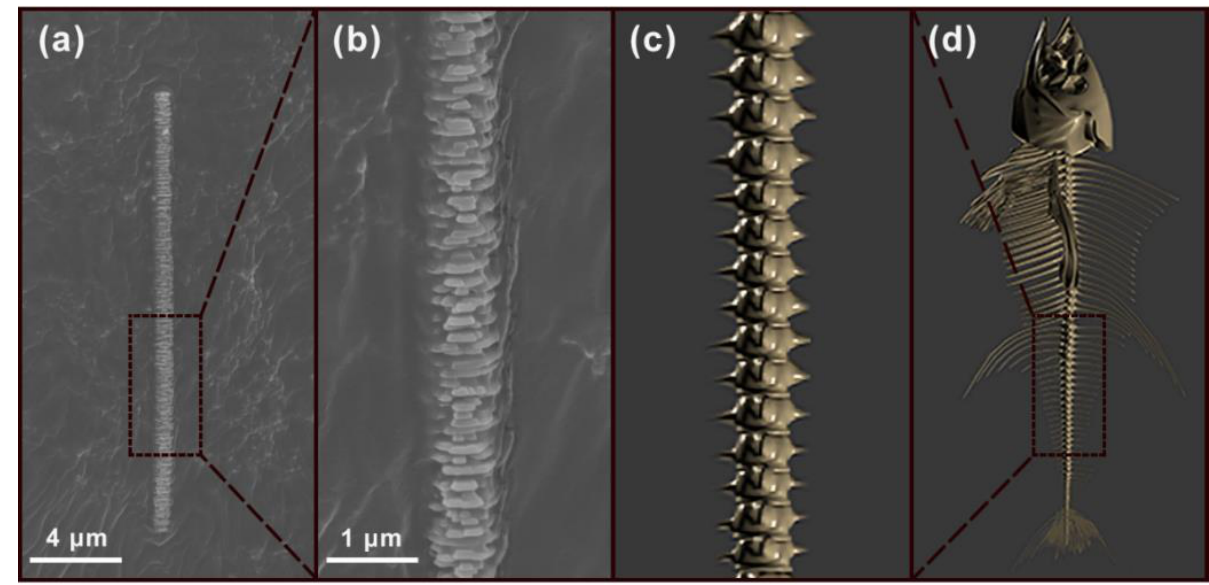
Figure 2. ( a ) and ( b ) SEM images of fishbone-like SiC; ( c ) and ( d ) schematic diagrams of a fish skeleton.